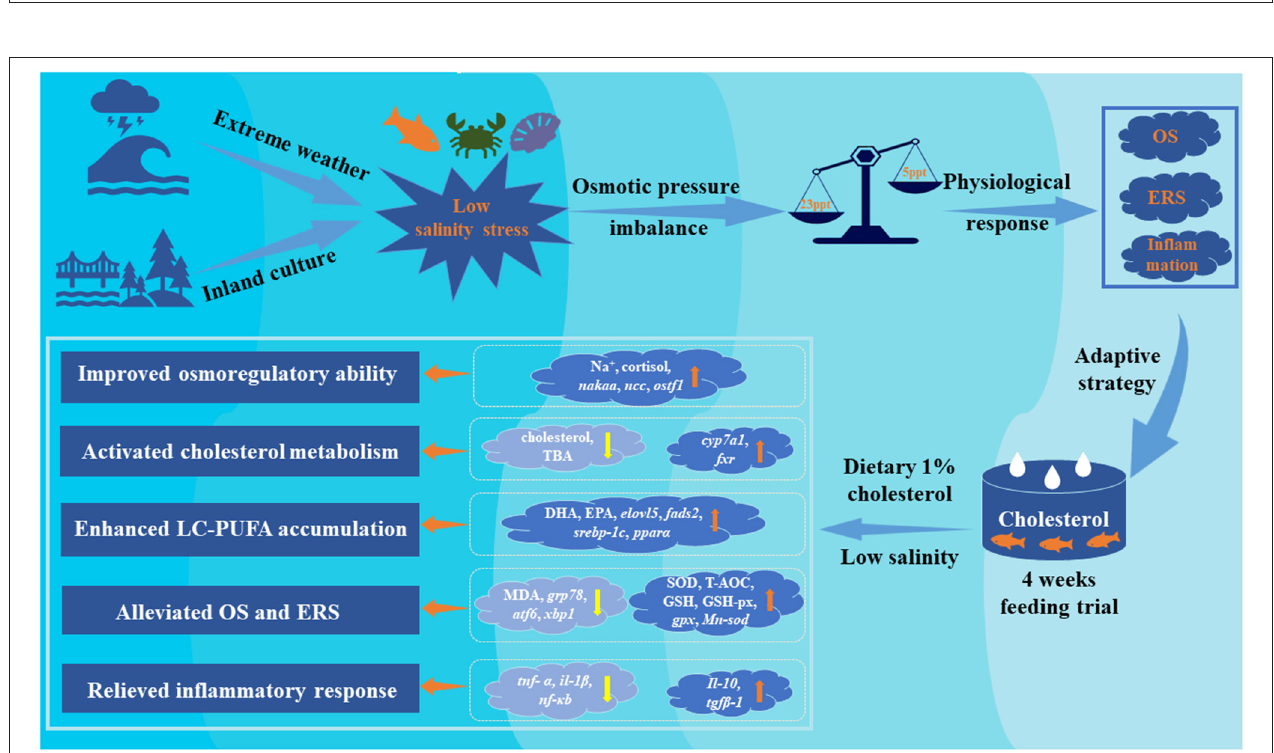
FIGURE 7 | Proposed regulatory strategies of dietary cholesterol supplementation on adaptive of euryhaline marine fishes to low salinity environment. Yellow arrows represent promotion/up-regulation, orange arrows represent repression/down-regulation.